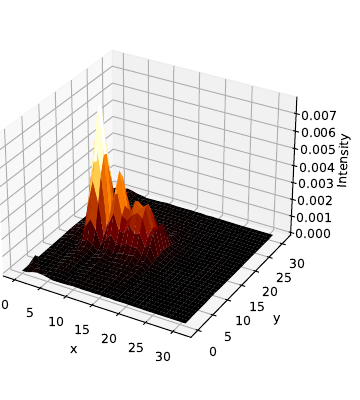
Figure 2. Average intensity at the detector for the oriented lamel- lar microemulsion with the strong correlation peak. Directions are x → Q z and y → Q parallel . The subpeak type modulation is an artifact induced by the analyzer mirror stacking.